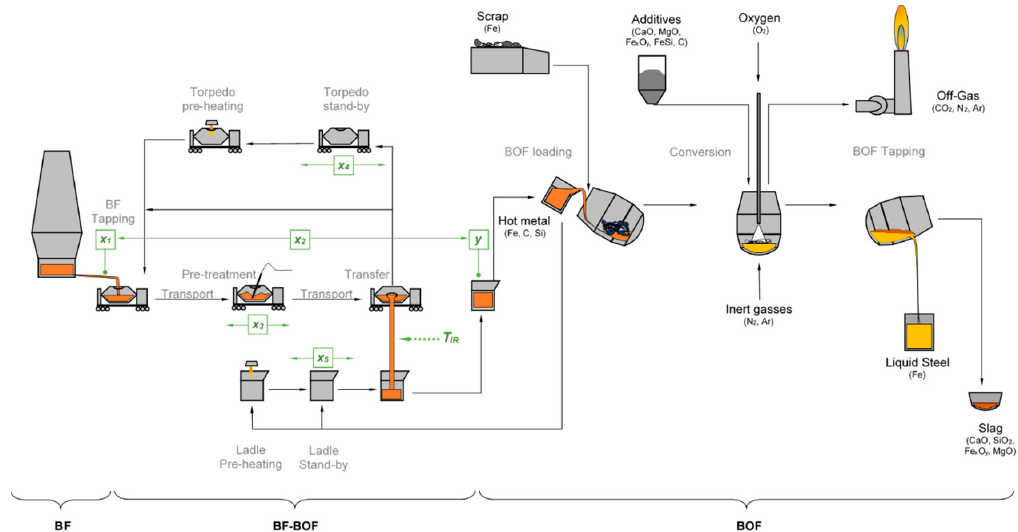
Figure 1. Scope of this research: a basic oxygen furnace (BOF) and the interface with the blast furnace (BF). The key aspects to be considered in this study are shown using different font colors: main materials (black), processes (gray) and process variables (green).